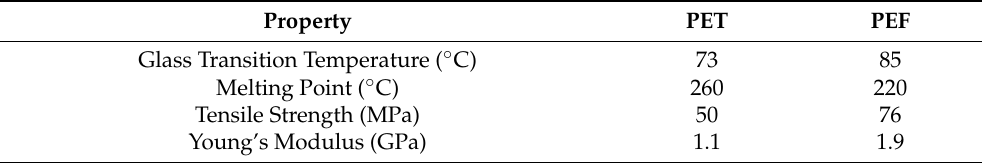
Table 1. Thermal and mechanical properties of poly(ethylene terephthalate) and poly(ethylene furanoate)